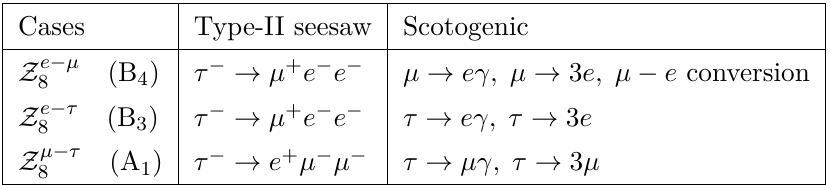
Table 4 . cLFV contribution from the type-II seesaw and scotogenic part of our model for the different symmetry cases Z e − µ , Z e − τ and Z µ − τ (see table 1) with effective neutrino mass textures B 8 8 8 B and A [see eq. (2.8)], respectively. 3 1